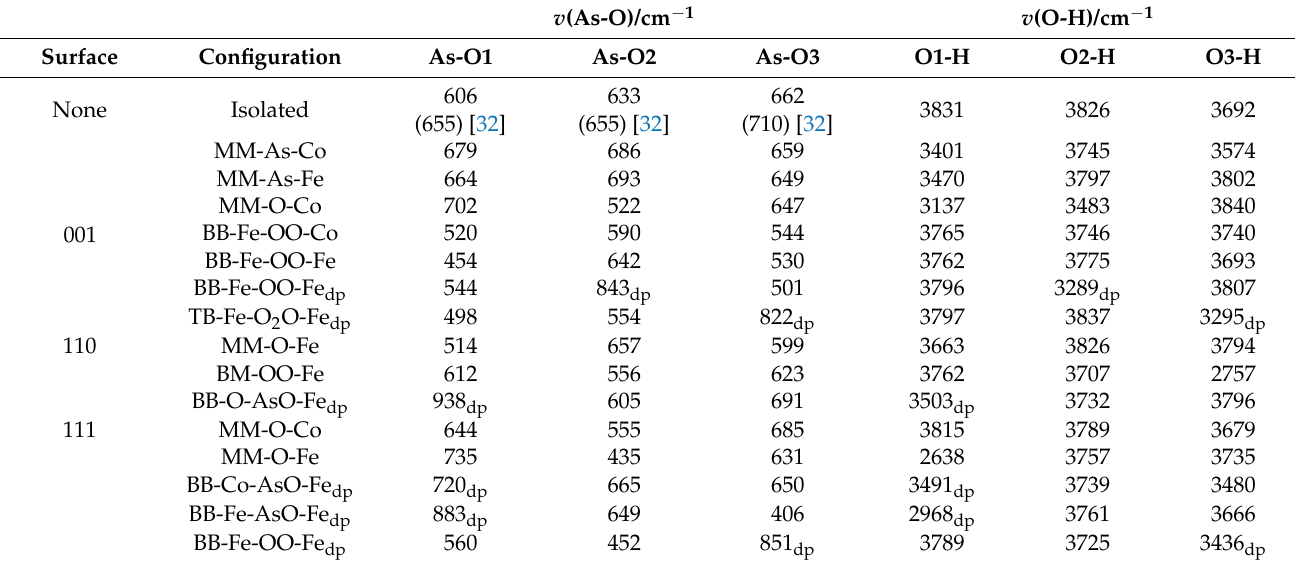
Table 3. Vibrational stretching frequencies of H 3 AsO 3 in isolation (with experimental values from the literature) and of all uniquely identified adsorption complexes on dry Fe 2 CoO 4 (001), (110), and (111) surfaces (dp = deprotonated).